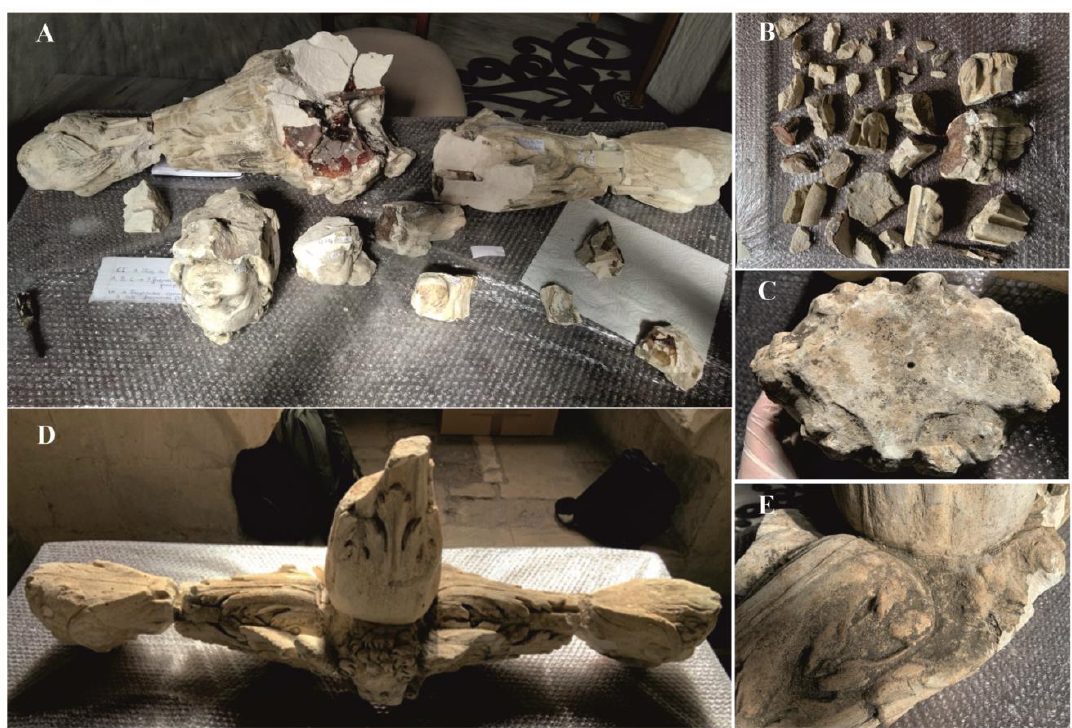
Figure 2. Vandalization of the Cross of the Inquisition. ( A , B ) Fragments of different sizes. ( C , E ) Fragments with black to brown crusts. ( D ) Reconstruction of some fragments.